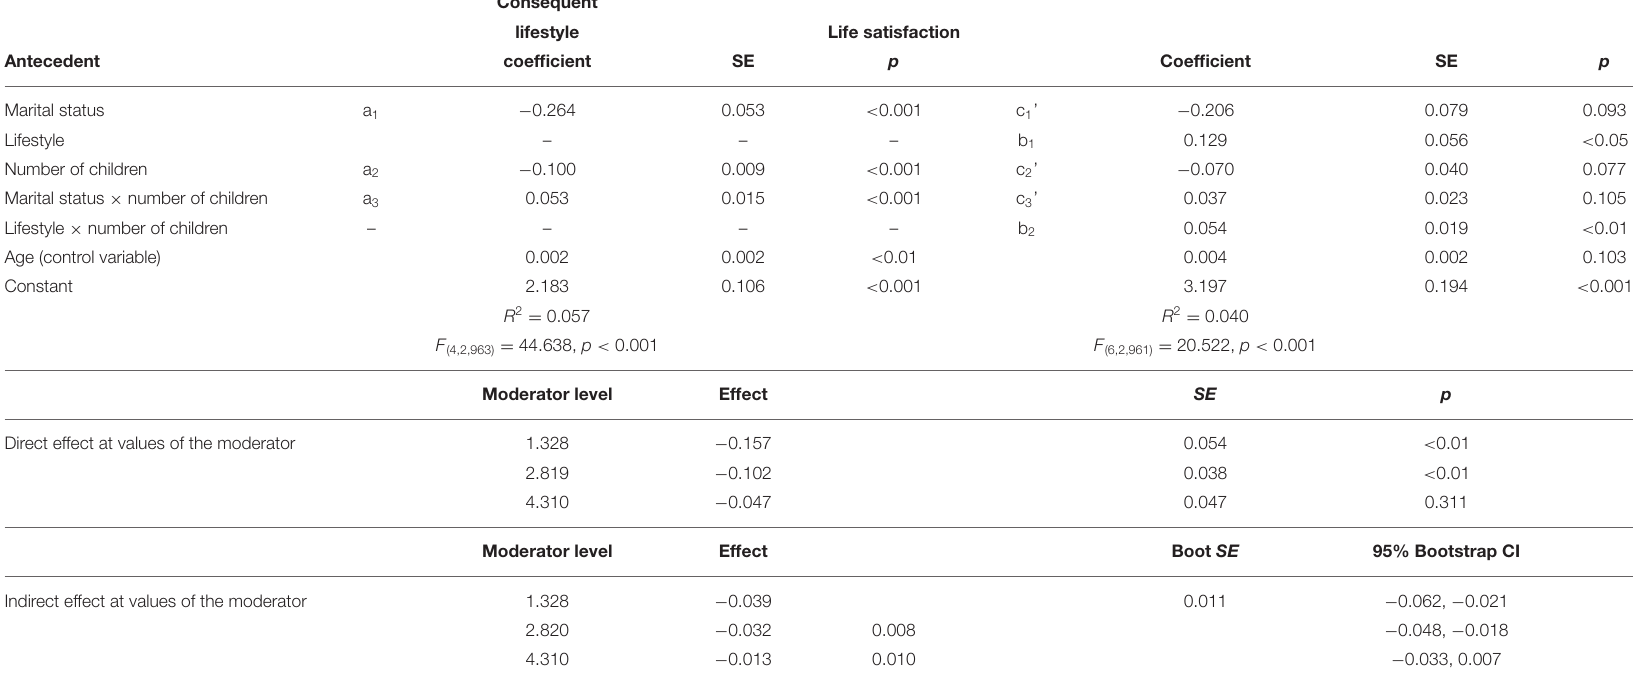
TABLE 4 | Results of moderated mediation